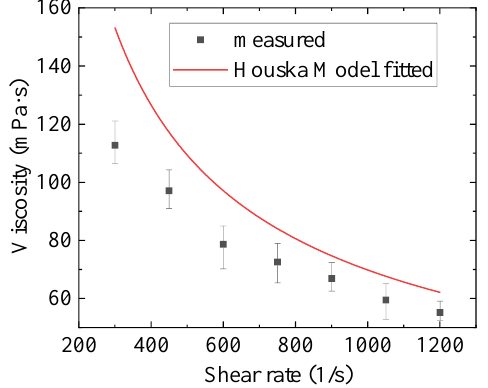
Figure A9. Toorman model steady-state fitting.